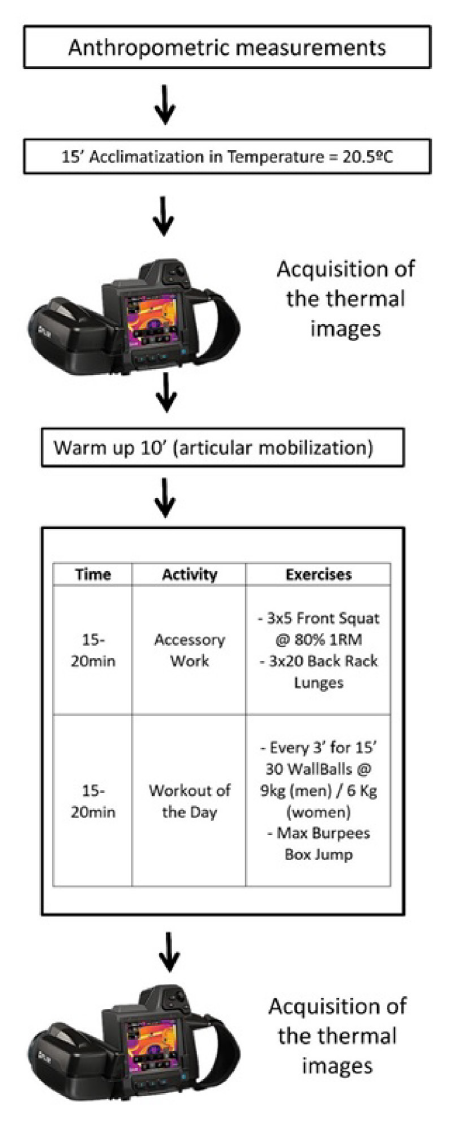
Figure 1 - Data collection